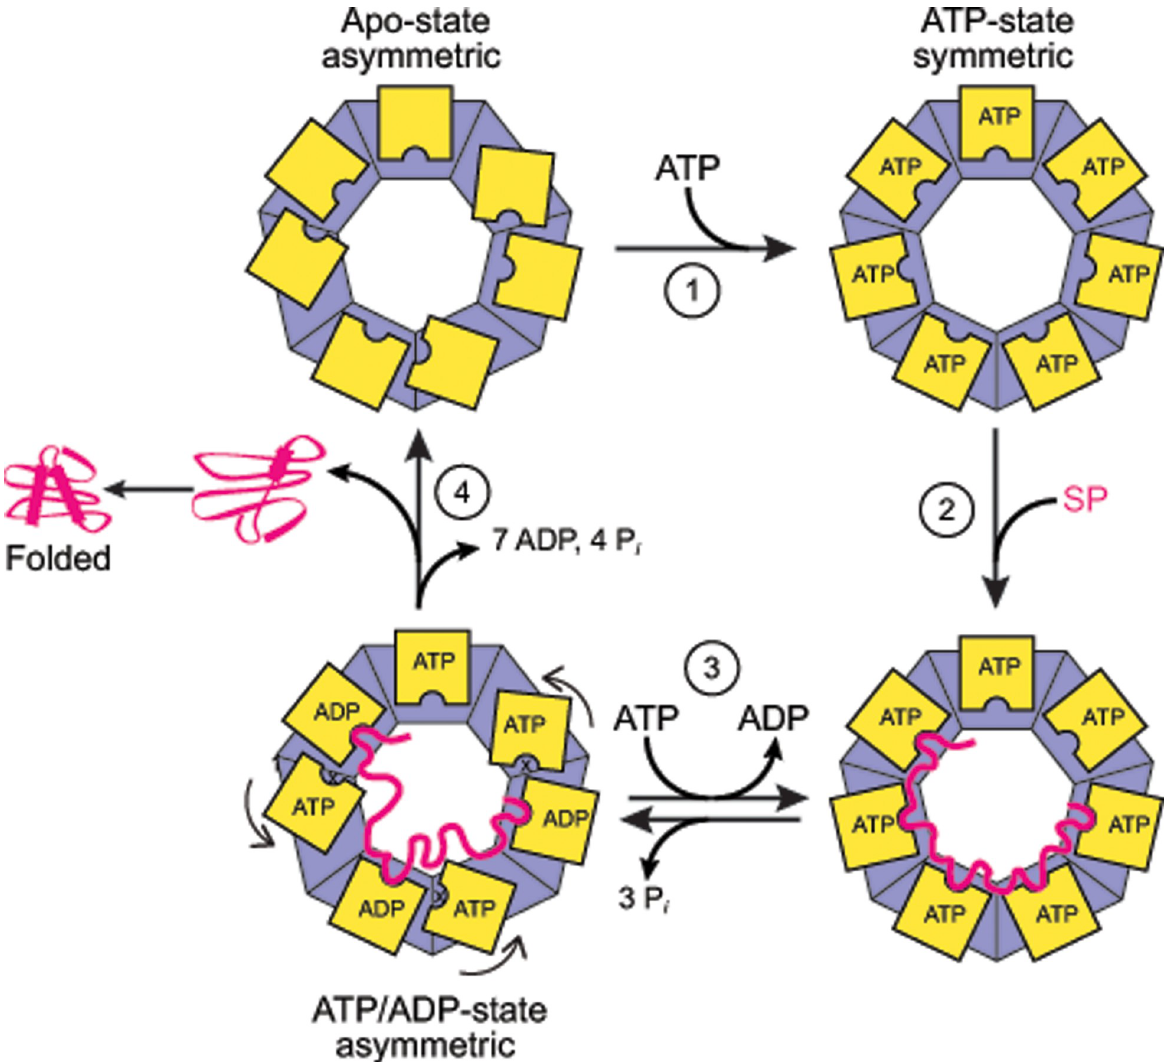
Fig 10. Hypothetical model for the ATPase and substrate interaction cycle of ɸ EL. ɸ EL is shown schematically as a top view with the apical domains in yellow. The double-ring apo-state with asymmetric apical domain orientation has only low affinity for SP. It is converted by ATP binding (1) to the single-ring characterized by symmetric apical domain topology and high binding affinity for SP (2). ATP hydrolysis in three alternating subunits (3) may result in partial SP release, with ATP hydrolysis in the remaining four subunits (4) completing SP release and